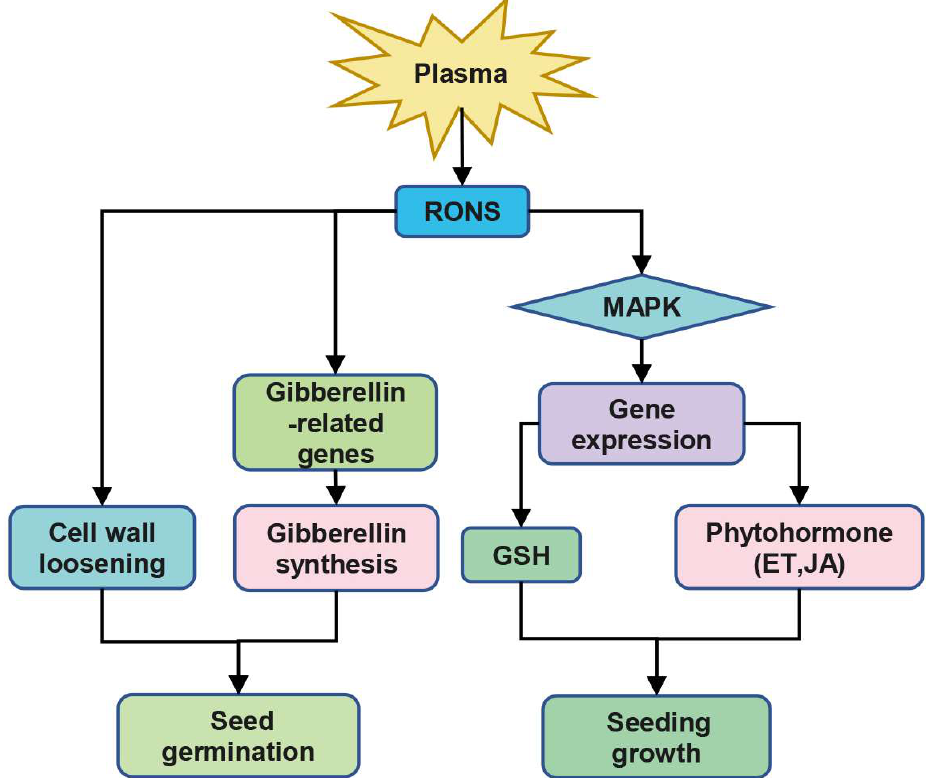
Figure 3. A simple mechanism for plant response to plasma. RONS, reactive oxygen and nitrogen species; MAPK, mitogen-activated protein kinase; GSH, glutathione; ET, ethylene; JA, jasmonic acid.